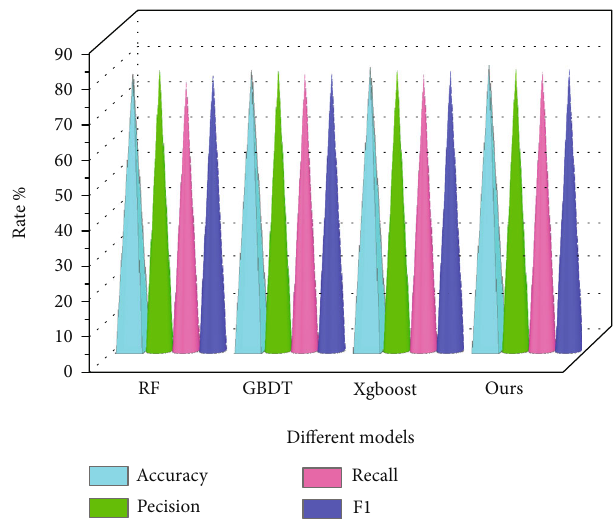
Figure 6: Comparison of prediction e ff ects between di ff erent models.